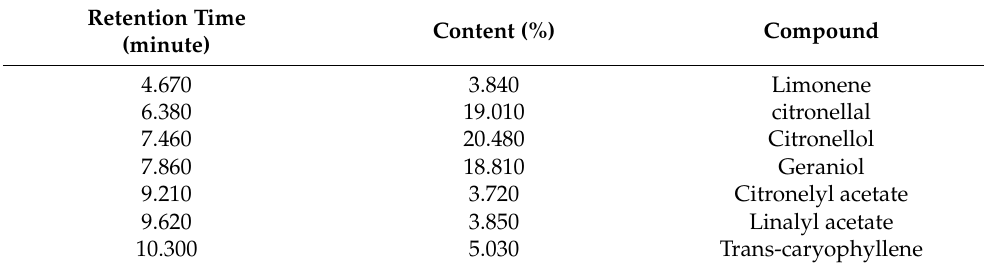
Table 5. Main Compounds of Citronella Oil.